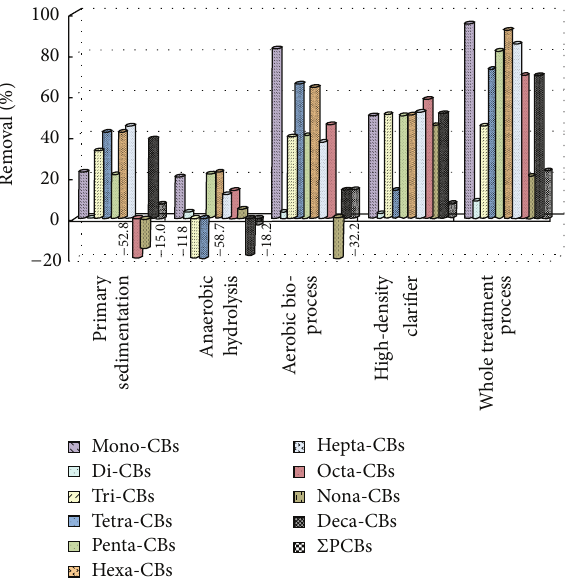
Figure 4: Mean removal percentages of dissolved PCB isomers during each treatment